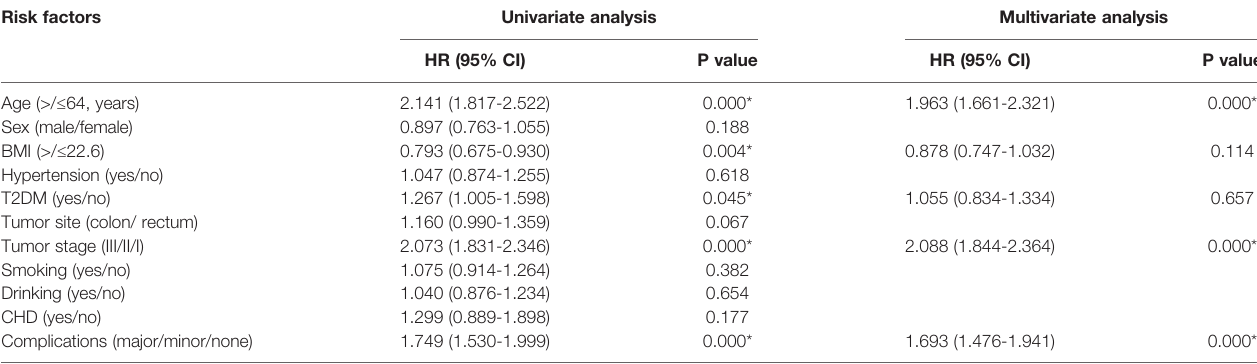
TABLE 3 | Univariate and multivariate analysis of overall survival.